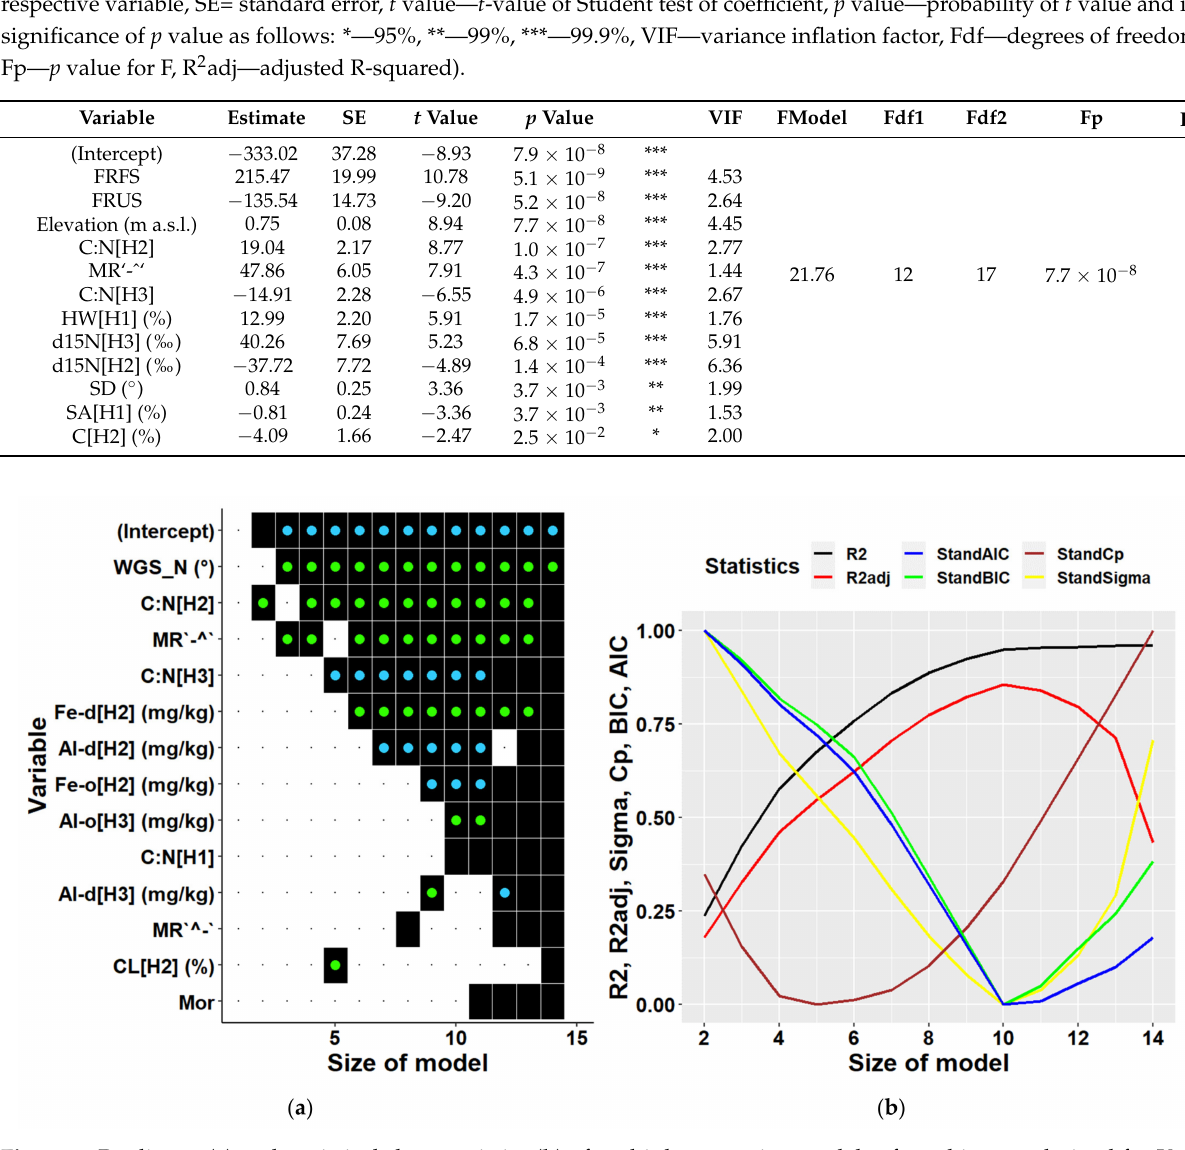
Figure 8. Predictors ( a ) and statistical characteristics ( b ) of multiple regression models of tree biomass derived for Keta location. Size of model represents the number of predictors included in the multiple regression model. Participation of individual variables in multiple regression models of biomass is indicated in the left figure by black squares, while black dots indicate their absence. Green dots inside black squares indicate significant positive impacts of respective variables, while blue dots represent their significant negative impacts. Predictors are identified by a combination of variable abbreviations, soil layers, and units if applicable as follows: Variables: Al-d—content of dithionite-extractable aluminium in (mg/kg), Al-o—content of oxalate-extractable aluminium in (mg/kg), C:N—C:N ratio, CL—clay fraction in (%), Fe-d—content of dithionite-extractable iron in (mg/kg), Fe-o—content of oxalate-extractable iron in (mg/kg), MR‘ˆ-‘—micro relief (concave terrain along the contour line and flat terrain along the slope), MR‘-ˆ‘—Micro relief (flat terrain along the contour line and concave terrain along the slope), WGS_N—latitude in ( ◦ ); soil layers presented in square brackets: H1—layer at 0–10 cm soil depth, H2—10–20 cm depth, H3—20–30 cm depth; statistical characteristics of derived models presented in figure ( b ) are as follows: R 2 —R-squared, R 2 adj—adjusted R-squared, AIC—Akaike information criterion, BIC—Bayesian information criterion, Cp—Mallows’ statistic, Sigma—residual standard